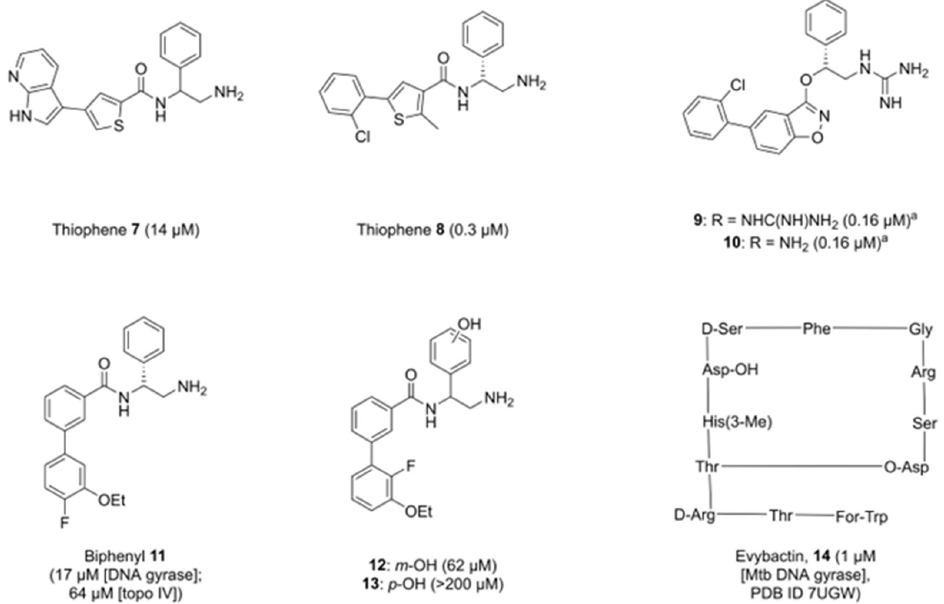
Figure 5. Inhibitors of bacterial DNA gyrase’s allosteric pocket, with IC 50 values against Escherichia coli DNA gyrase in brackets unless stated otherwise. Thiophene compounds 7 and 8 were the basis for further developments into a fused ring system as well as a biphenyl system, whereas evybactin was identified as an antimycobacterial compound before the target was elucidated. a A different assay was used to test the IC 50 of 9 and 10 compared to all other compounds noted here [44], which utilised fluorescence spectroscopy in comparison to an agarose-gel-based assay used to test compounds 7 , 8 , 11 – 13 . As a result, they appear to be comparatively better, but are noted as being less potent than thiophene 8 , which was found to have an IC 50 value of 0.04 µ M when tested in the same assay conditions as 9 and 10